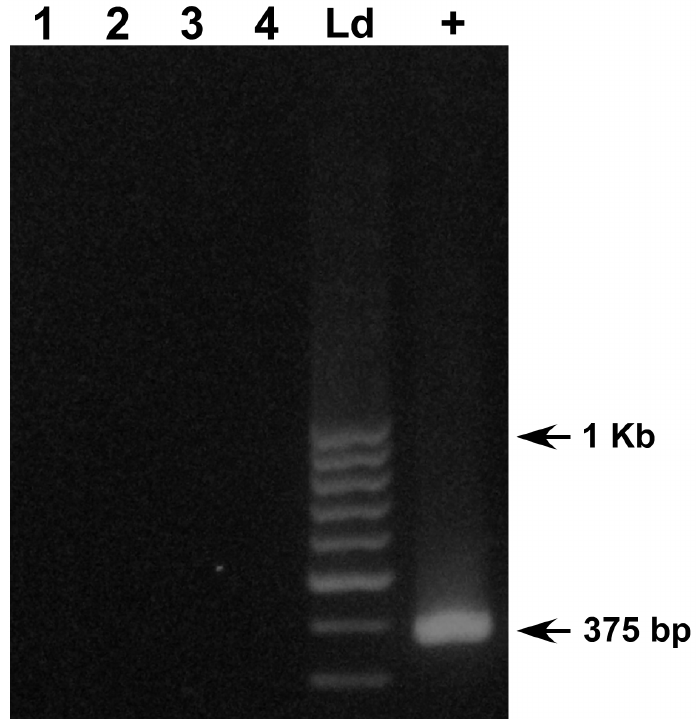
Figure 2. Specificity of the PCR-based assay for Helicobacter spp. detection: DNA extracted from E. coli bacteria (1-4) and DNA extracted from feces of a mouse that was previously diagnosed with Helicobacter infection (+) were used as the input of the PCR. Labels: 1-4: respectively, 100, 10, 1 or 0.1 ng of E. coli DNA, MW = 100 bp DNA ladder; (+ positive control) 100 ng of Helicobacter spp. DNA; 1% agarose gel (ethidium